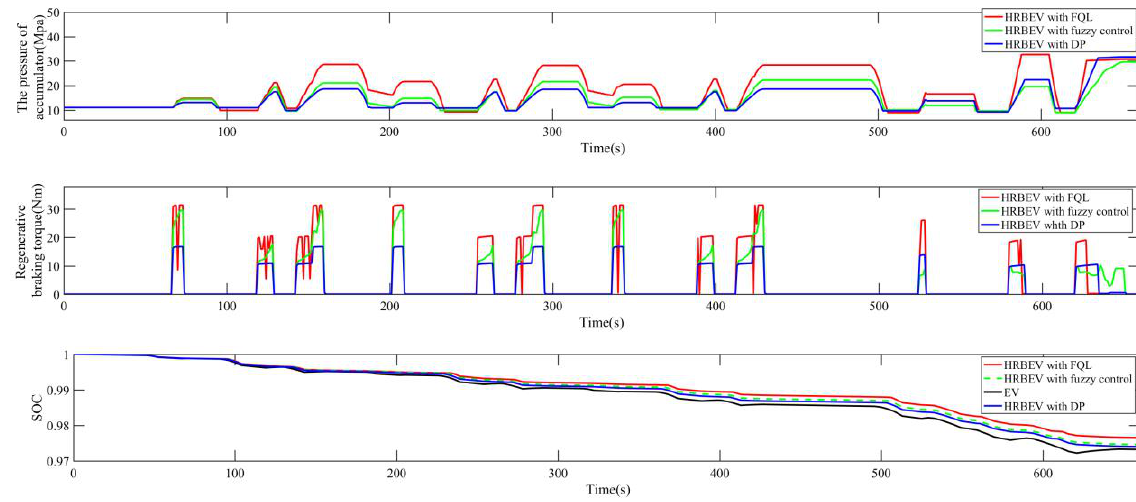
Figure 11. Simulation results under the 1015 cycle.